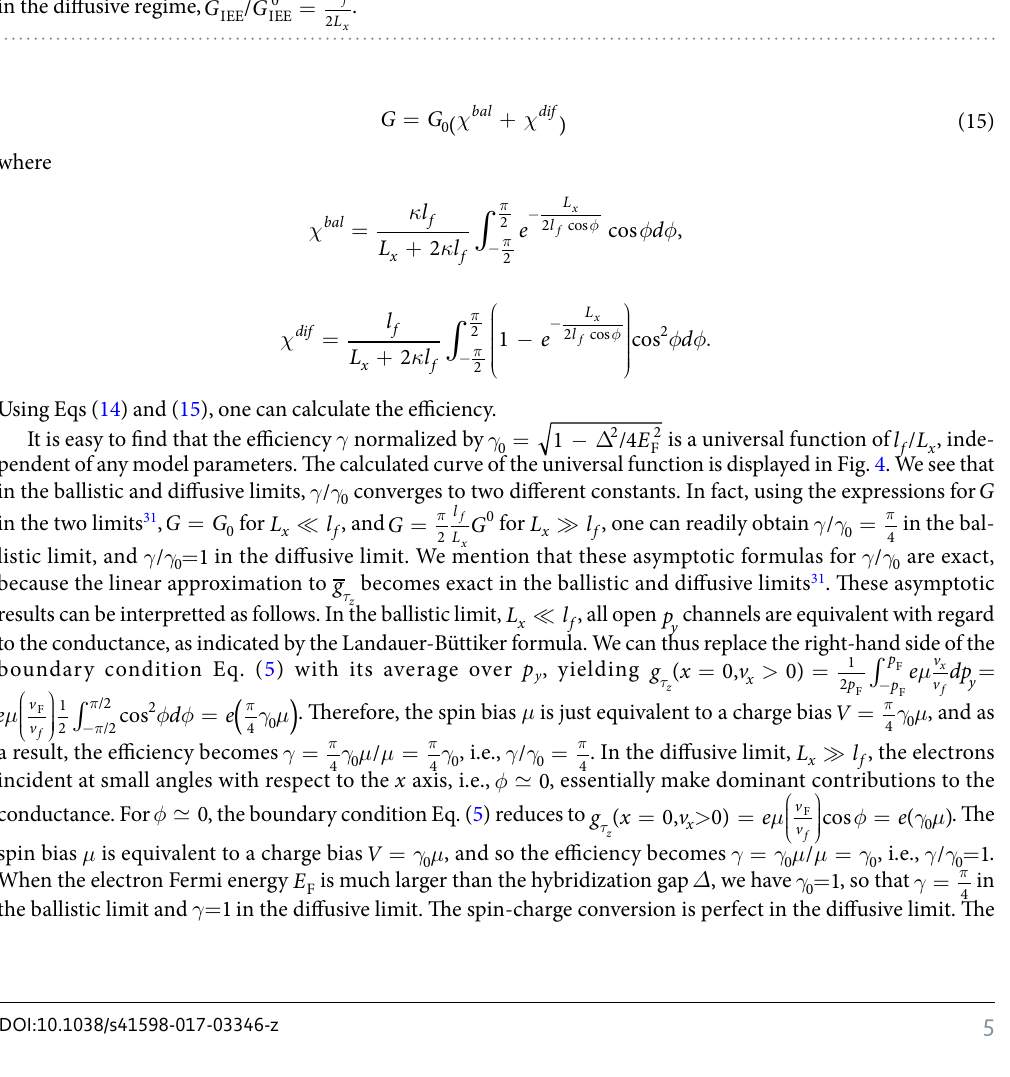
Figure 3. ( a ) Normalized electrical current due to the IEE as a function of normalized coordinate x L / for x several different values of l L / . ( b ) IEE conductances as functions of l L / calculated from exact numerical f x f x solution and approximate formula Eq. (14). The black solid line stands for the result of the Landauer-Büttiker IEE0 like formula in the ballistic regime, = π G G / , and the black dashed line stands for the Drude like formula IEE π 4 in the diffusive regime, =